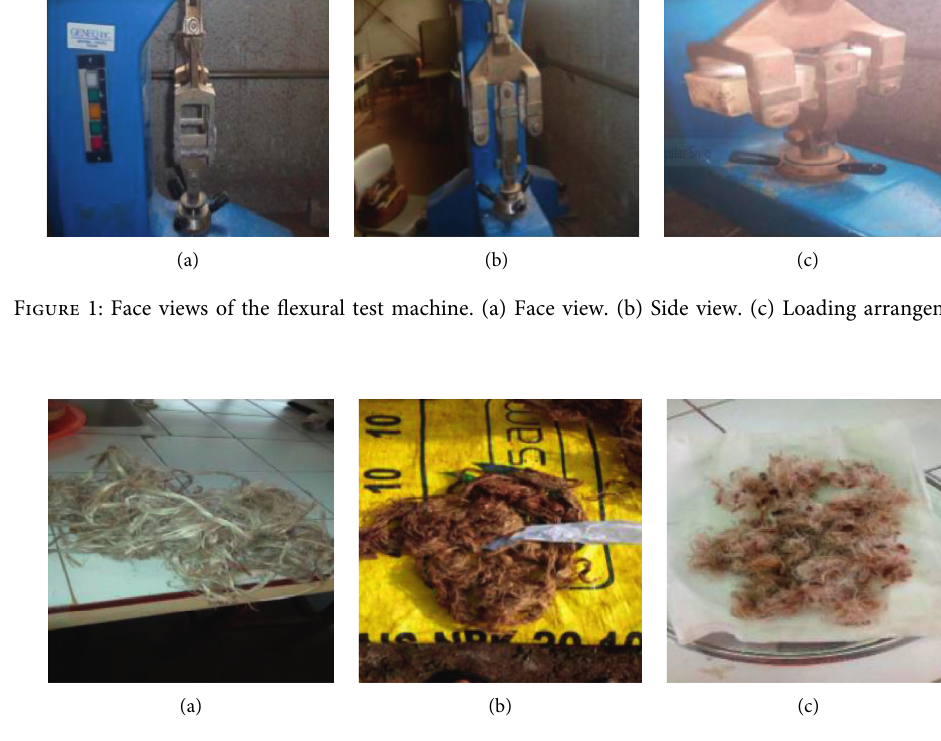
Figure 2: Fibres obtained from (a) washing, (b) treatment with caustic soda, and (c) dewaxed fibres.